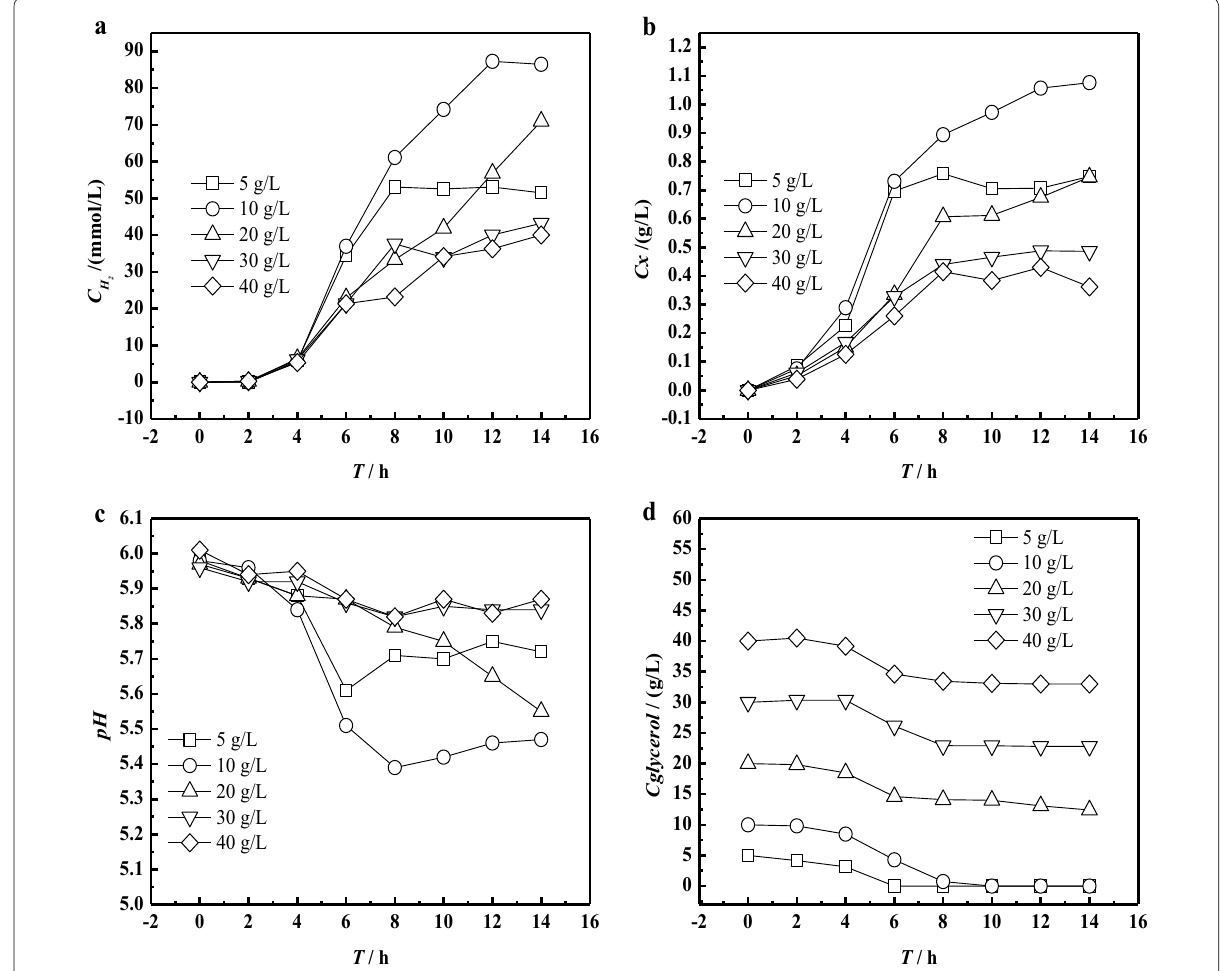
Fig. 11 The effect of different initial glycerol concentration on H 2 \ C x \pH\ C glycerol during EB-06 glycerol fermentation: a C H2 , b C x , c pH, and d C